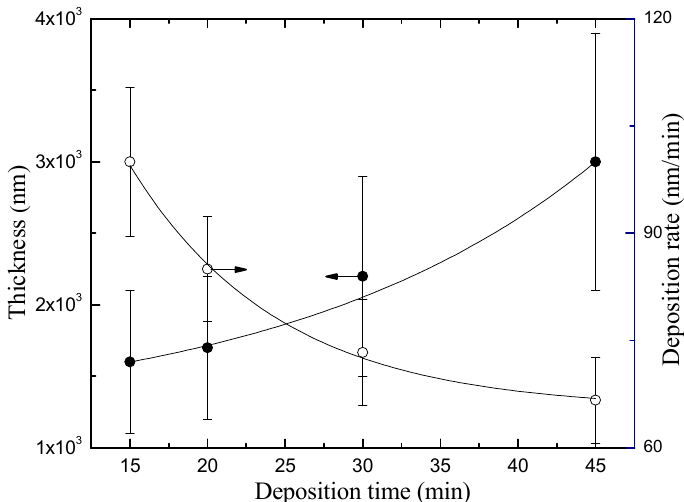
Figure 4. Thickness and deposition rate of plasma deposited films as a function of deposition